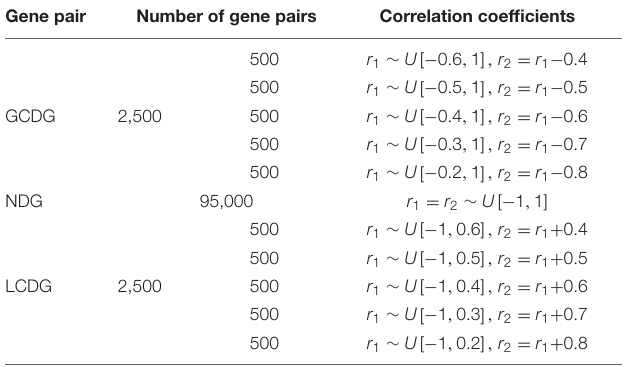
TABLE 1 | The simulation data with 100,000 gene